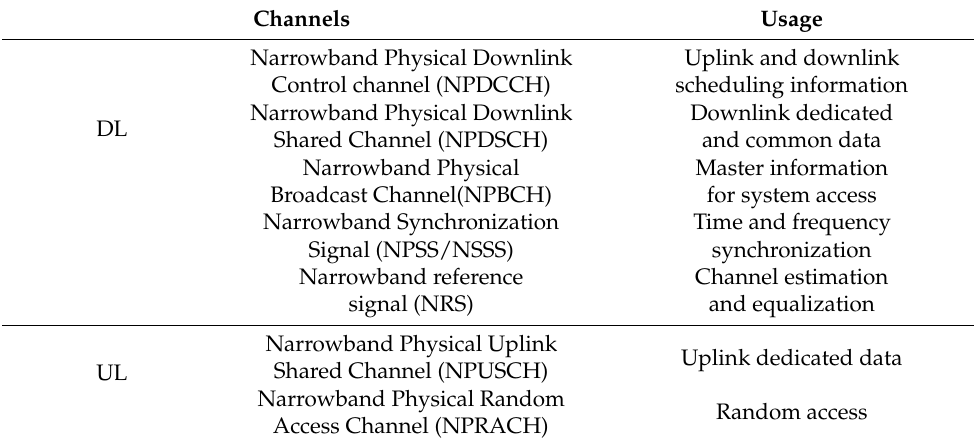
Figure 1. Deployment modes of NB-IoT: ( a ) in-band operation; ( b ) guard-band operation; and ( c ) stand-alone operation mode. Table 1. NB-IoT channels and signals.